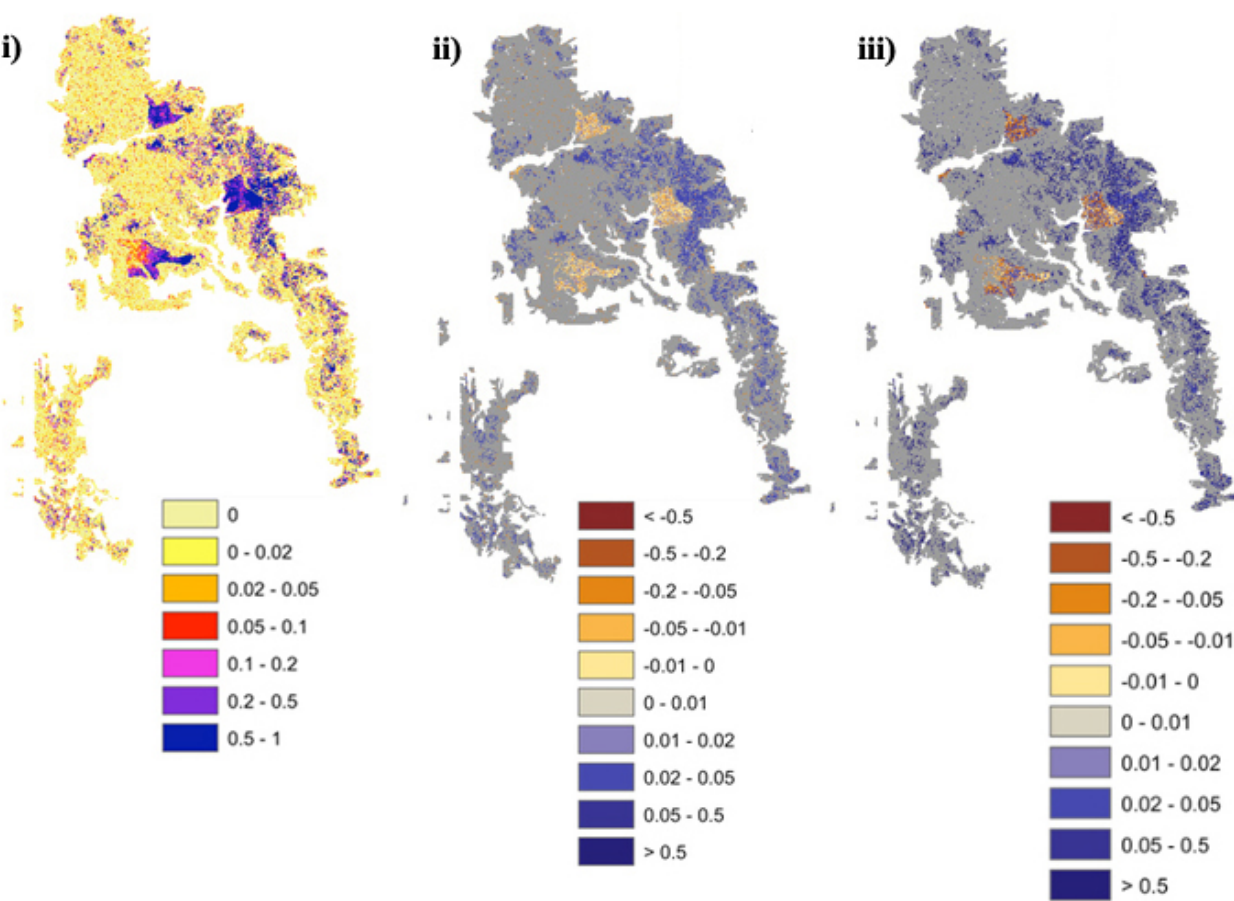
Fig. 3 . Heather fraction and changes between 2009-2030: (i) current heather fraction; (ii) future heather fraction under current management; and (iii) future heather fraction in response to the “farmers as wildlife and carbon managers”